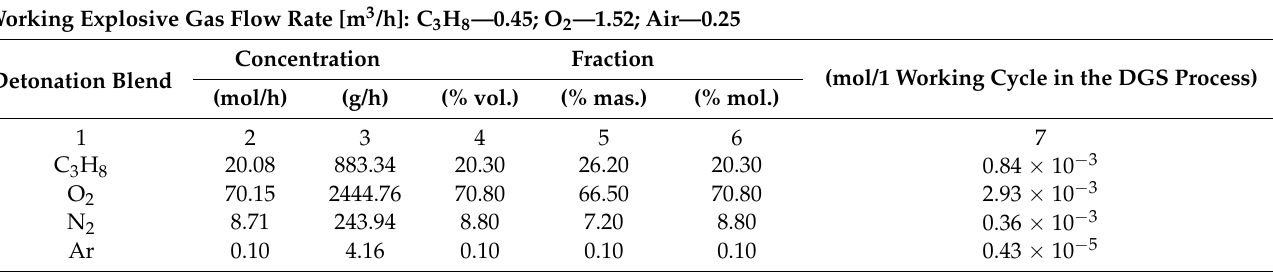
Table 2. Composition of detonation combustion products at DGS spraying of the Fe40Al at.% powder particles. Working Explosive Gas Flow Rate [m 3 /h]: C 3 H 8 —0.45; O 2 —1.52; Air—0.25 Detonation